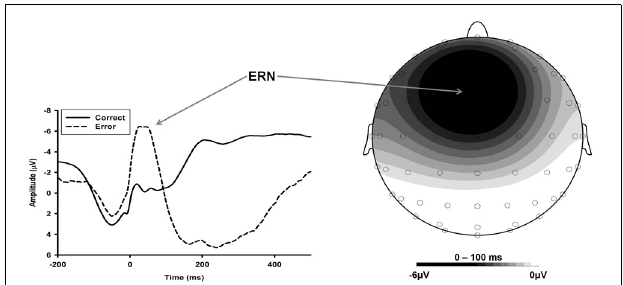
FIGURE 1 | ERN Waveform and Voltage Map. Neural activity recorded in the post-response period during a flanker task. Response-locked waveform is presented on the left. Dashed line: the ERN is shown as the negative deflection peaking at approximately 50ms; the ERN is followed by a broad, positive deflection—the error-positivity. Solid line: the CRN is the correct-response counterpart to the ERN. It shows a similar time course and scalp distribution. A voltage map depicting the scalp distribution of the ERN is presented on the right. It shows that the ERN is primarily a fronto-centrally maximal